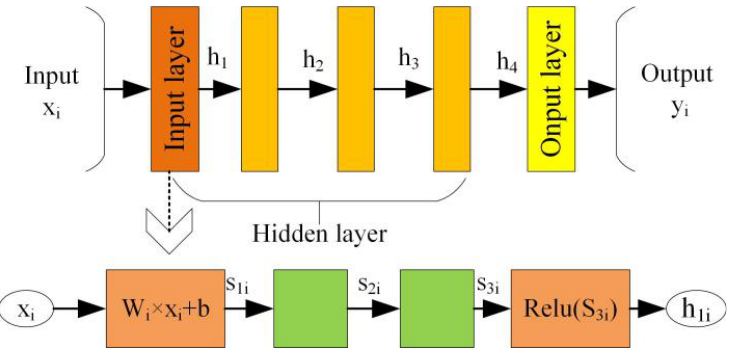
Figure 5. Schematic diagram of BN.